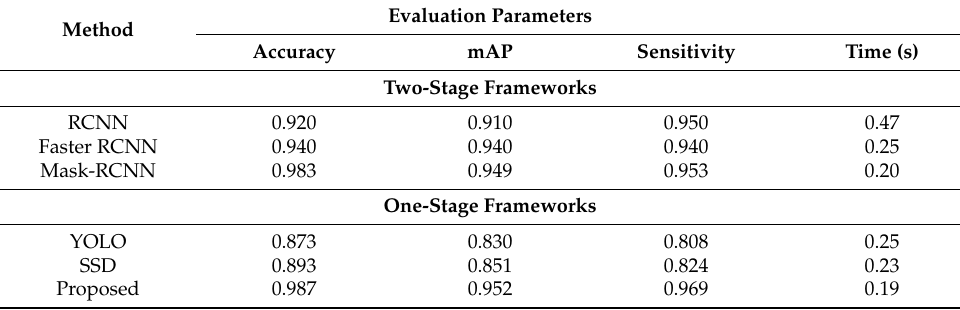
Table 4. Comparative analysis with other techniques.